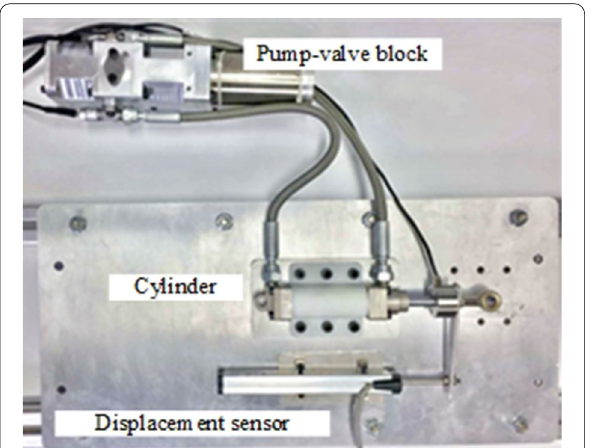
Figure 12 Test bench of HAS system identification